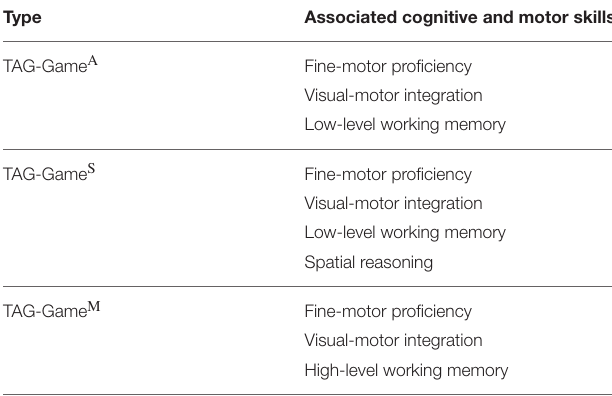
TABLE 1 | Three types of TAG-Games and cognitive skills expected to be associated with each